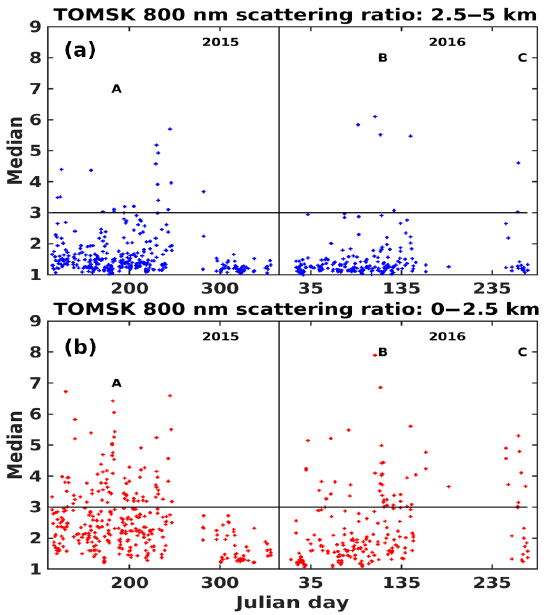
Figure 7. Time evolution from April 2015 to September 2016 of the median of the 808nm Tomsk lidar backscatter ratio for two altitude ranges: 0–2.5km (b) and 2.5–5km (a) . A, B and C are the cases analysed in Sect. 5.